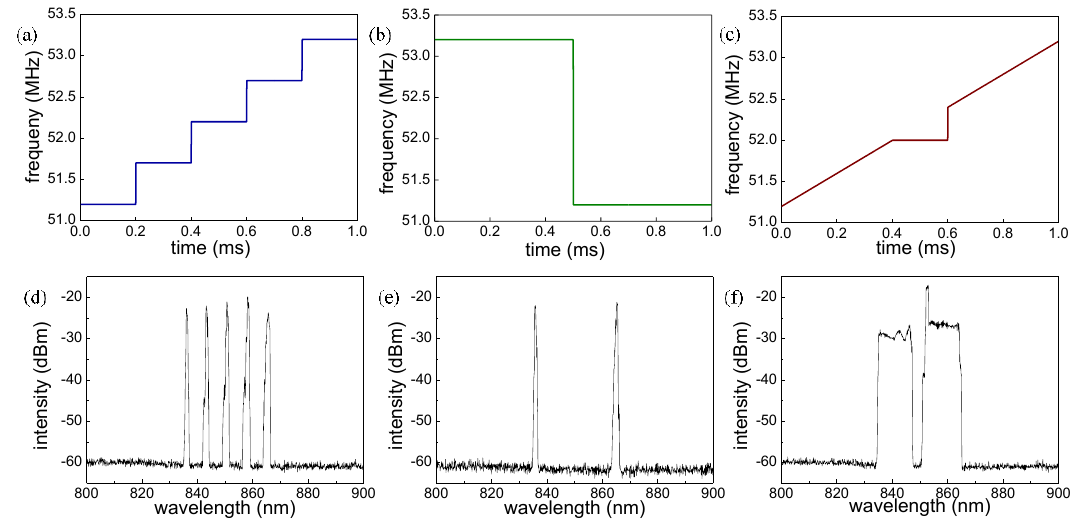
Figure 5. The various drive functions; ( a ) staircase wave function; ( b ) square wave function; and ( c ) dual-band wave function. Their corresponding output spectra with peak hold mode are also shown in ( d ), ( e ), and ( f ), respectively.